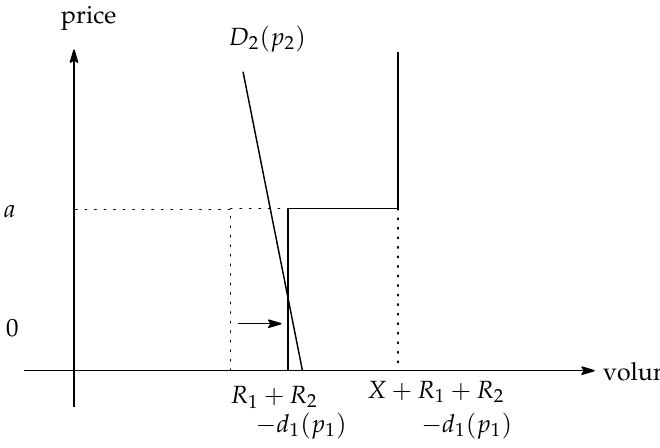
Figure 4. Date 2 market equilibrium with higher p 1